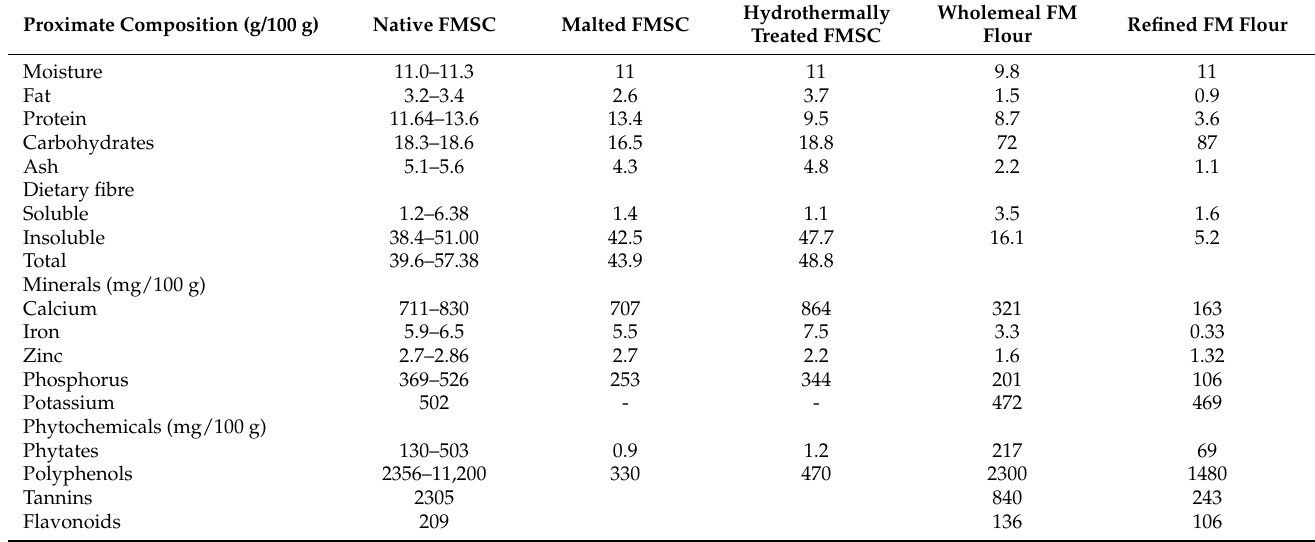
Table 2. Nutritional composition of wholemeal, refined flour and seed coat matter of finger